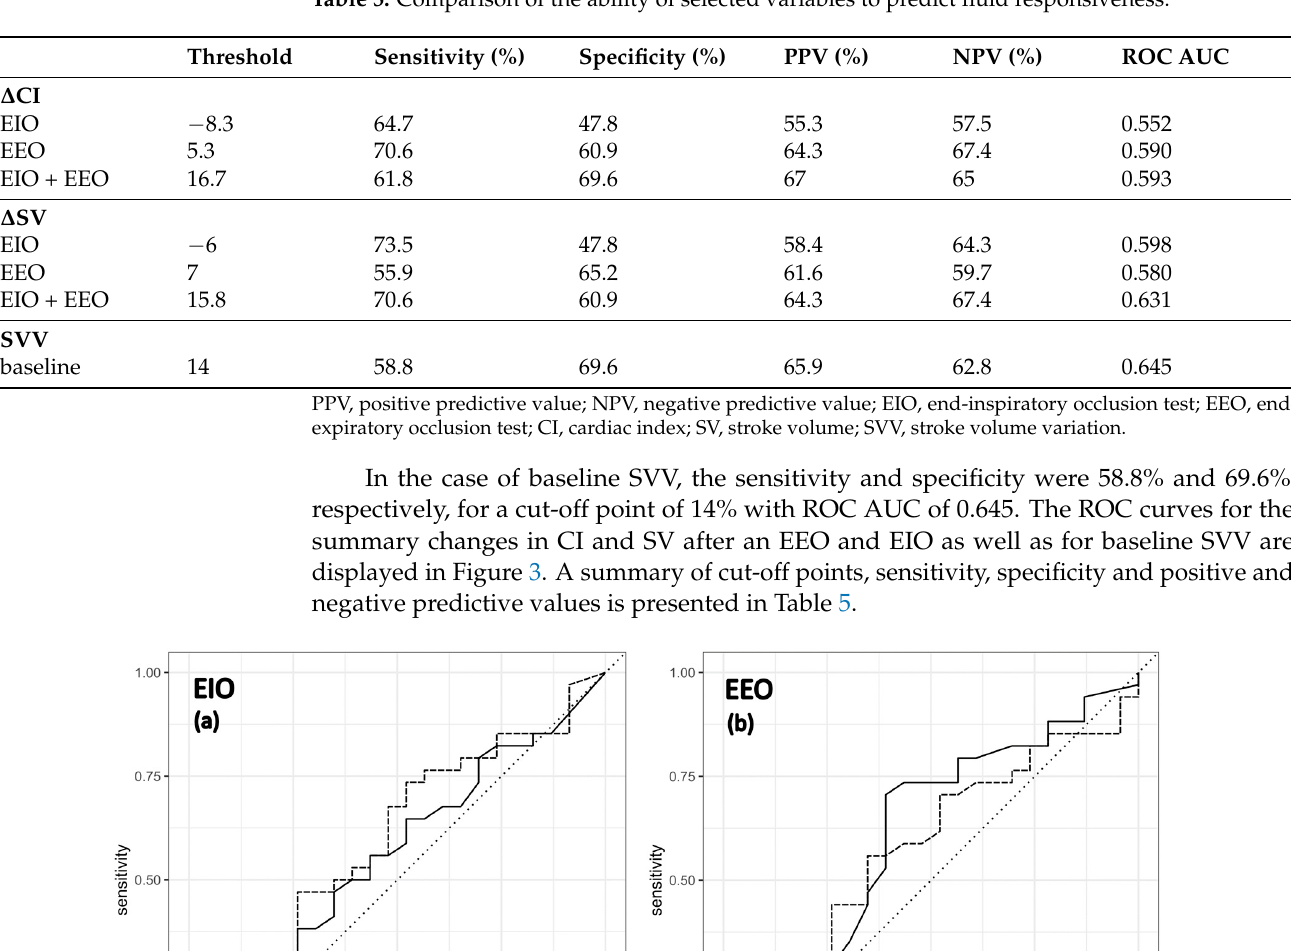
Figure 3. Receiver operating characteristic (ROC) curves evaluating the ability of changes in CI and SV to predict fluid responsiveness during ( a ) EIO, ( b ) EEO and ( c ) combined EIO and EEO maneu- vers; ( d ) shows the ROC curve of fluid responsiveness prediction based on baseline SVV. 4. Discussion Our study did not confirm the previously reported accuracy of EEO for predicting fluid responsiveness in elective cardiac surgical patients in the ICU. Several explanations can be proposed for this discrepancy, as well as the limitations of this study. The EEO test has been increasingly used to predict fluid responsiveness with excellent results in the operating theatre [18,20] and the ICU [12,14,16,22]. Because the diagnostic threshold of EEO is close to the accuracy of routinely employed methods, especially echocardiography [13,32,33], Jozwiak et al. combined the changes induced by EEO and EIO, increasing the diagnostic threshold of CO change to 13% while keeping excellent sensitivity and speci- ficity [13]. These results were replicated in a later study by Depret et al. [14]. In the case of EEO, a recent meta-analysis of 13 studies showed a pooled sensitivity of 0.85 and speci- ficity of 0.88 with ROC AUC 0.91 at the threshold change in CO of 5.1% [15]; there was no significant difference between studies using pulse contour analysis or echocardiography to assess these changes and the test remained reliable at different PEEP settings and vari- able tidal volumes. Nevertheless, several studies also report a failure of respiratory occlusion tests to predict fluid responsiveness reliably. In a study by Guinot et al. [24], failure of EEO in